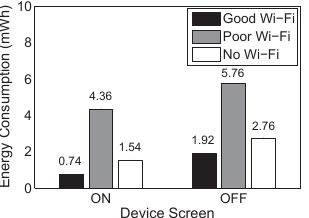
Figure 3: Default Wi-Fi energy consumption for one minute under various screen activation